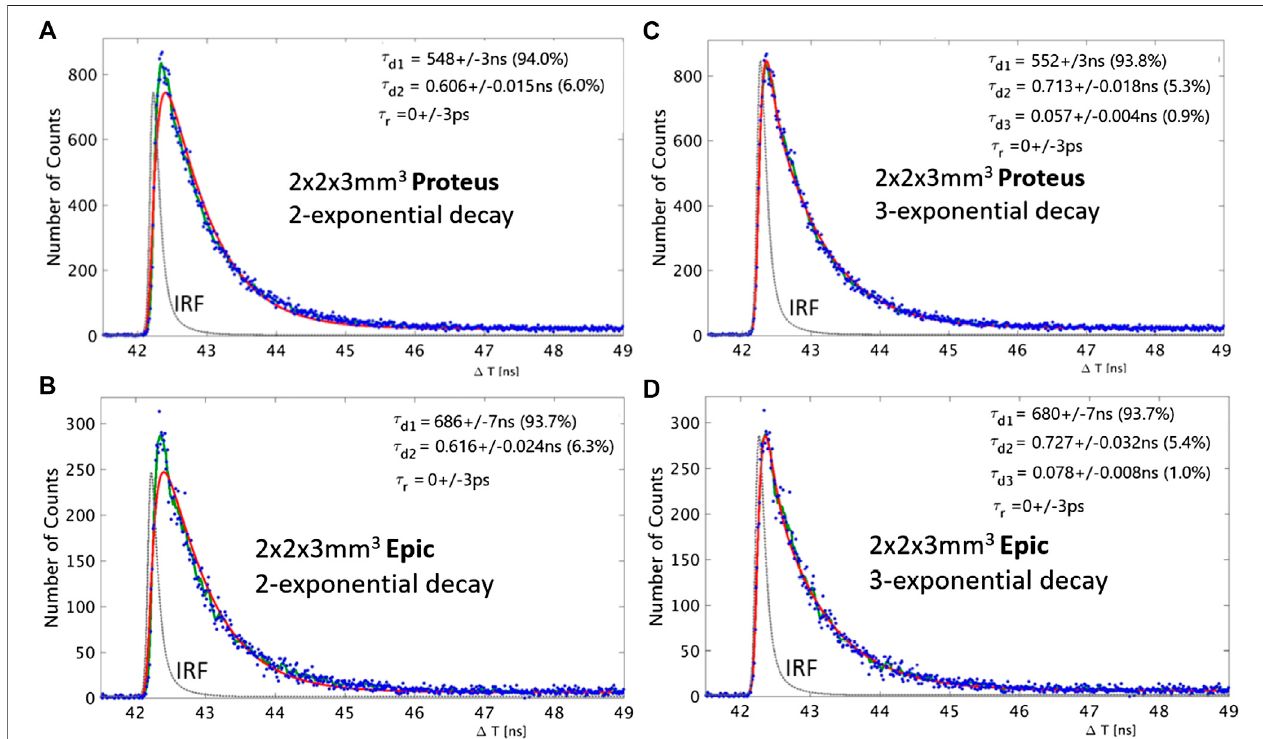
FIGURE 6 | Time correlated single photon counting measurements under X-ray excitation, with 3 mm long BaF 2 crystals from Proteus (A , C) and Epic (B , D) , measuredwithagateof2 µs.Thethinblackdottedlineshowstheimpulseresponsefunction(IRF)ofthesetup.Thegreenlineisawalkingaverageandtheredlinea fi tof the data. (A , B) : the data was fi tted with a double exponential decay. (C , D) : the data was fi tted with a triple exponential decay. The graphs show that the triple exponential decay function fi ts better the fastest part of the emission curve.